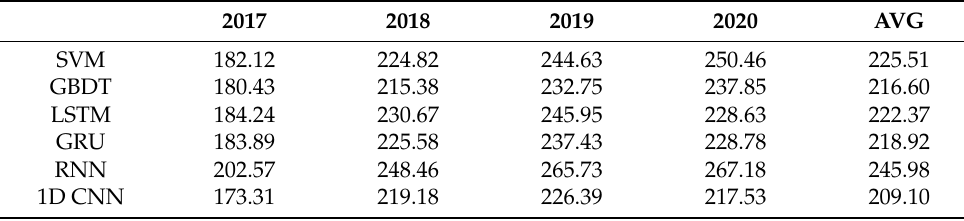
Table 5. Twenty-four hour distance error in cross component